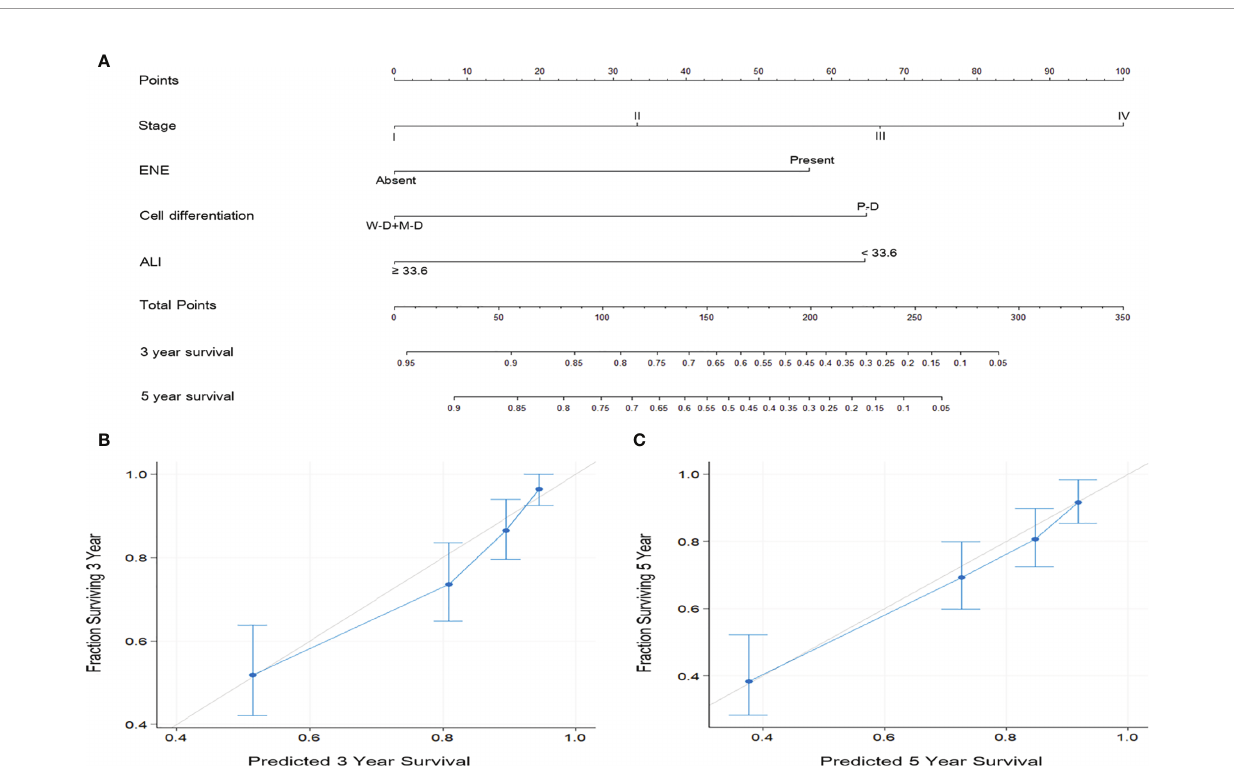
FIGURE 4 | (A) Nomogram based on ALI and independent prognostic factors for OS prediction. Each parameter is included as a line segment on the nomogram, and the points on the line segment indicate the degree of risk contributed by this parameter. Addition of the points for all parameters yields the total points corresponding to the 3- and 5-year OS rates for the individual patient. (B, C) Calibration plots of the nomogram for (B) 3-year and (C) 5-year OS prediction. The light gray 45° line indicates the ideal prediction, and the blue line represents the value predicted by the nomogram